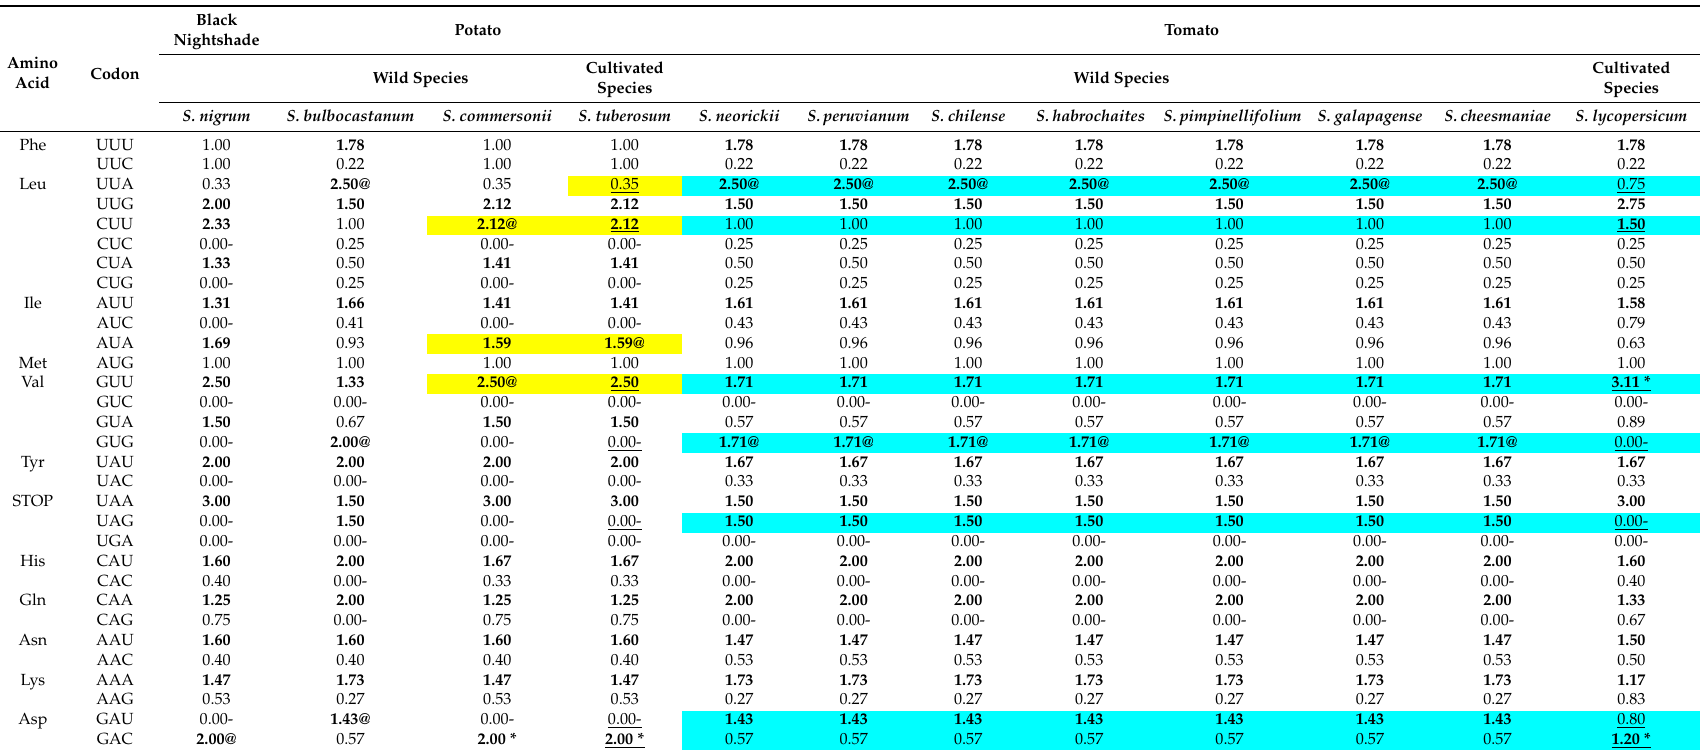
Table 3. The relative synonymous codon usage (RSCU) values of twelve Solanum chloroplast genomes. The optimal codons, preferred codons and rare codons were identified by the RSCU values. The optimal codon, marked with * ( p < 0.01) and @ ( p < 0.05) was defined as a codon whose usage frequency in the high-expression genes was significantly higher than in the low-expression genes by the chi-squared contingency test. The preferred codon (shown in bold) was a codon with the RSCU value more than 1 (RSCU > 1), whose investigated usage frequency is more than the expected one. Whereas the rare codon (marked with -) was a codon with the RSCU less than 0.1 (RSCU < 0.1), representing a very low usage frequency. Green background: There were only two different RSCU values between the wild S. commersonii and the cultivated S. tuberosum ; while others were the same between the chloroplast genomes. Yellow background: Within the same RSCU values between the wild S. commersonii and the cultivated S. tuberosum , the different optimal codons were identified using the same chi-squared test. Blue background: The notable differences between the cultivated S. lycopersicum and seven wild tomatoes. RSCU values underlined: The preferred codon patterns of the cultivated tomato S. lycopersicum were different from those of the seven wild tomatoes, but similar with those of cultivated potato S. tuberosum